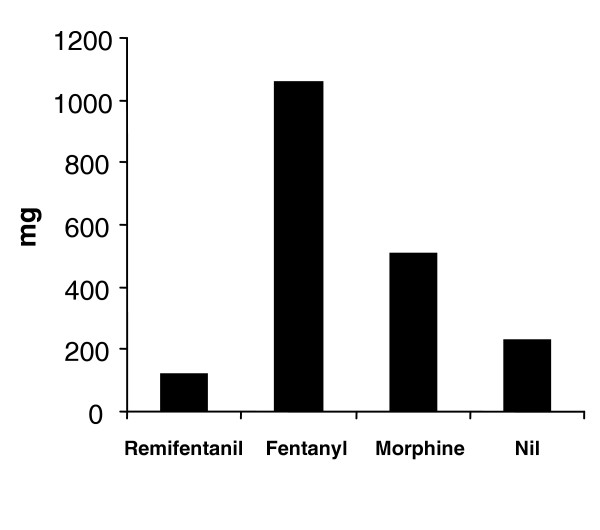
Mean total midazolam dose.